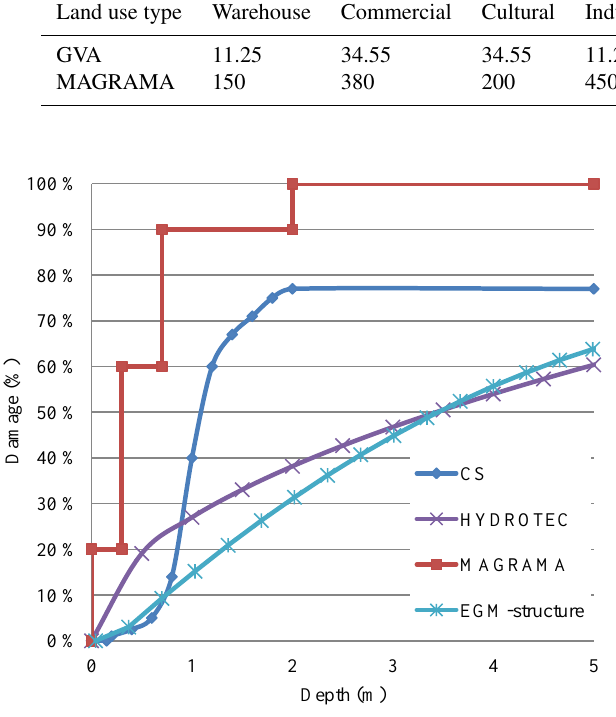
Table 9. Reference costs in EURm − 2 in urban areas: GVA (2015) and MAGRAMA (2013). Land use type